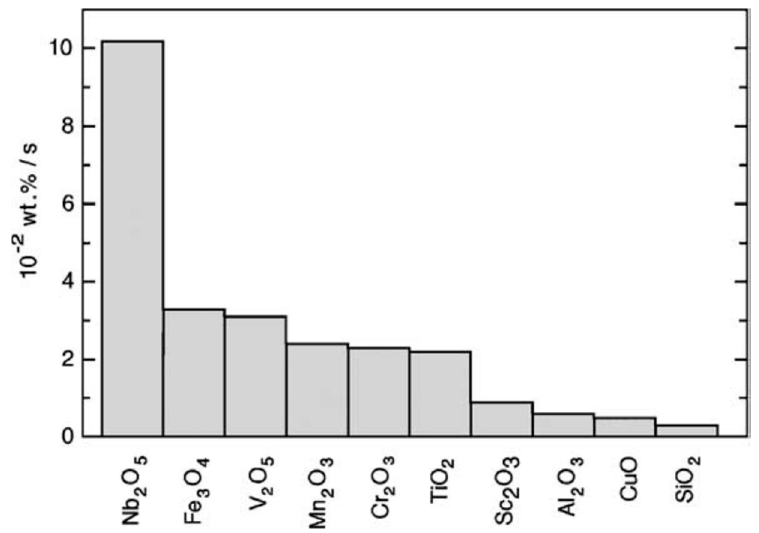
Figure 1. Comparison of the desorption rates of MgH 2 with different metal oxide catalyst additions at 300 °C into vacuum [112].